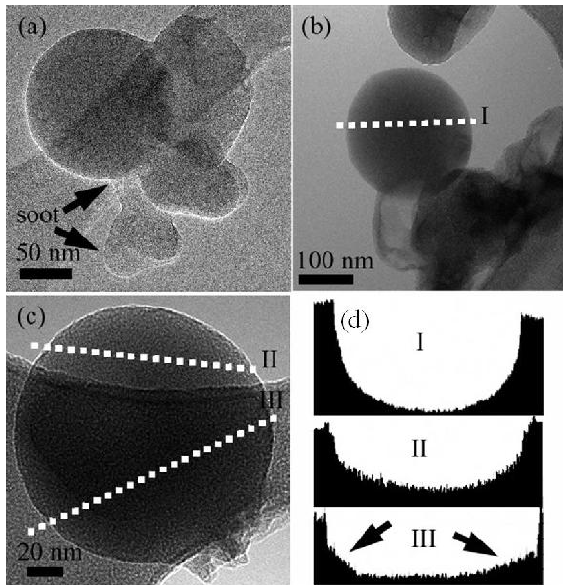
Figure 6. TEM images of amorphous carbonaceous spheres collected at 120 m. (a) a sphere2 Fig. 6. TEM images of amorphous carbonaceous spheres collected at 120 m. (a) A sphere mixed with soot particles (arrow), and (b) a mixed with soot particles (arrow), and (b) a sphere mixed with possibly organic residue. (c) a3 sphere mixed with possibly organic residue. (c) A sphere on the car- sphere on the carbon support film. (d) Line profiles (I, II, III) come from the dashed lines4 bon support film. (d) Line profiles (I, II, III) come from the dashed across the spheres in image b and c.5 lines across the spheres in image (b) and (c) .